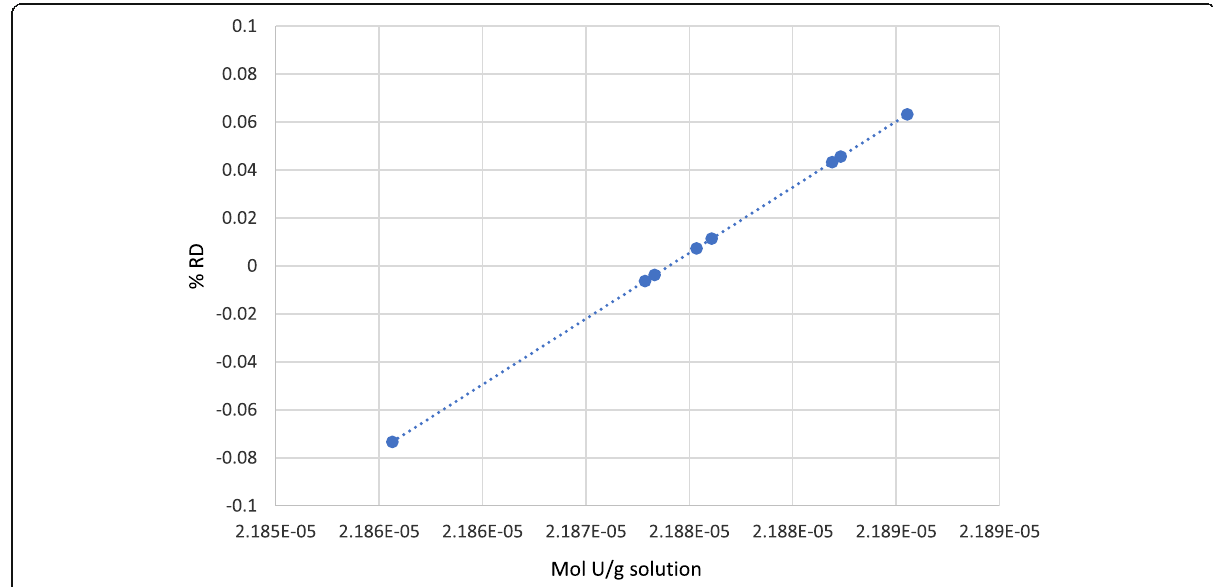
Fig. 2 U-content (Mol U/g solution) in the unknown sample (CRM 149) as a function of RD% in the simulated